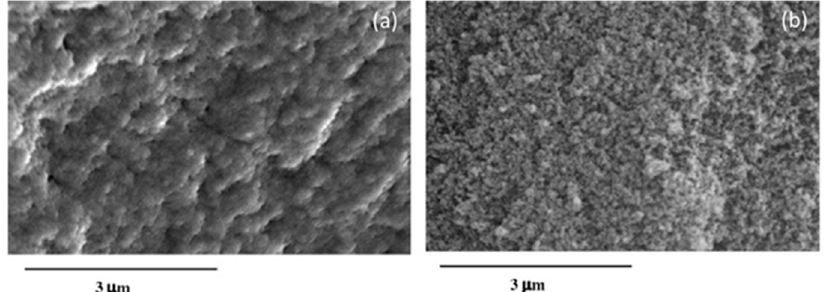
Figure 19. SEM images for a ( a ) xerogel and ( b ) an aerogel. The porous diameters in the first case are between 20 and 40 nm; for the second one, they are above 50 nm. Reprinted from [80] with permission from Elsevier.